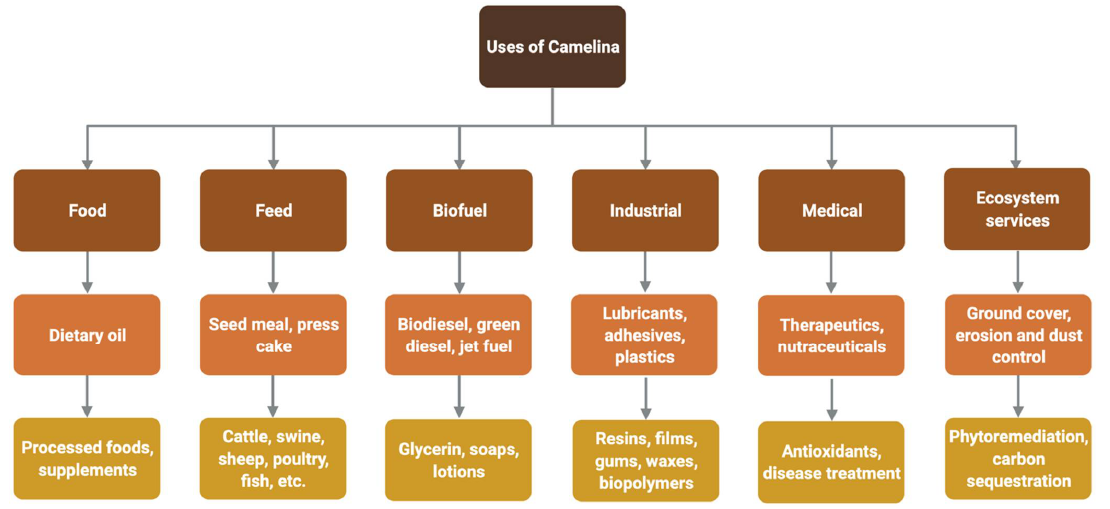
Figure 2. Diverse uses of C. sativa adapted from Chaturvedi et al., 2017 [17]. Created with BioRen-